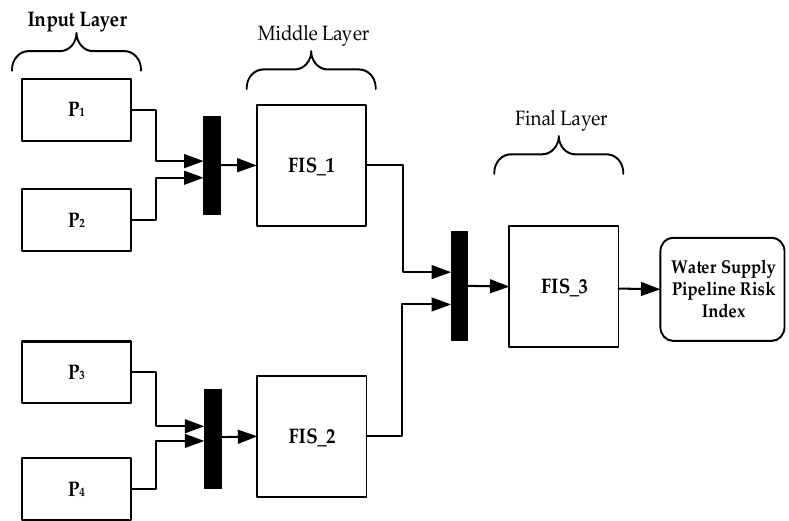
Figure 2. Proposed cohesive hierarchical fuzzy inference model.